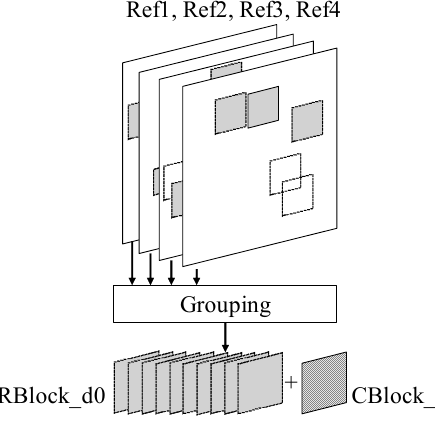
Figure 2. IME-based patch grouping.